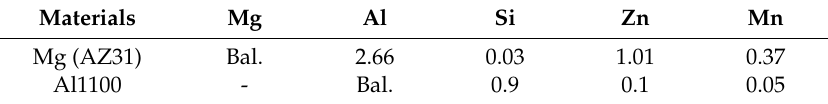
Table 1. Chemical composition (wt%) of materials